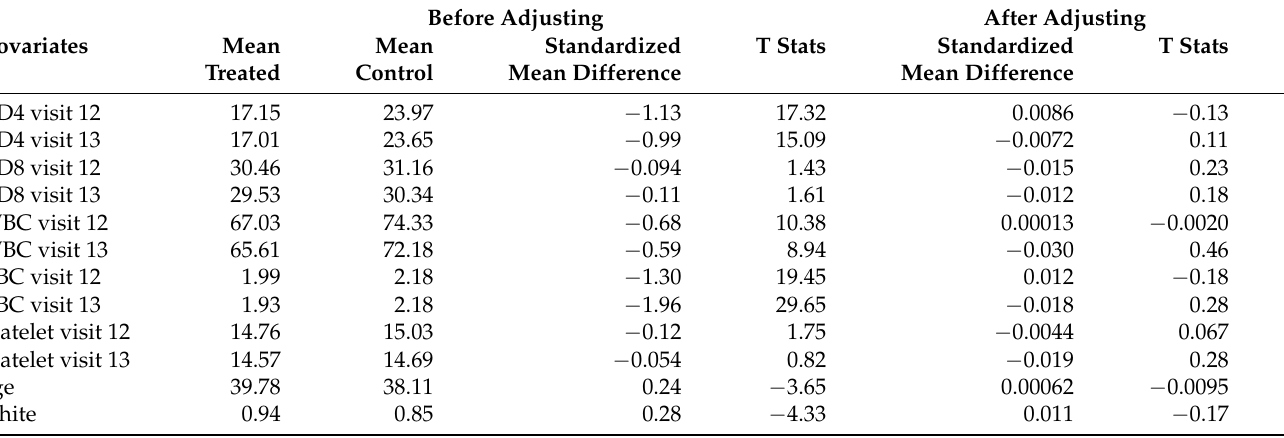
Table A1. MACS dataset: Balance of covariates between the treated and the control groups. We regressed each covariate on the spline of the logit of the propensity of treatment; a truncated linear basis with 10 equally spaced knots was used. Before Adjusting After